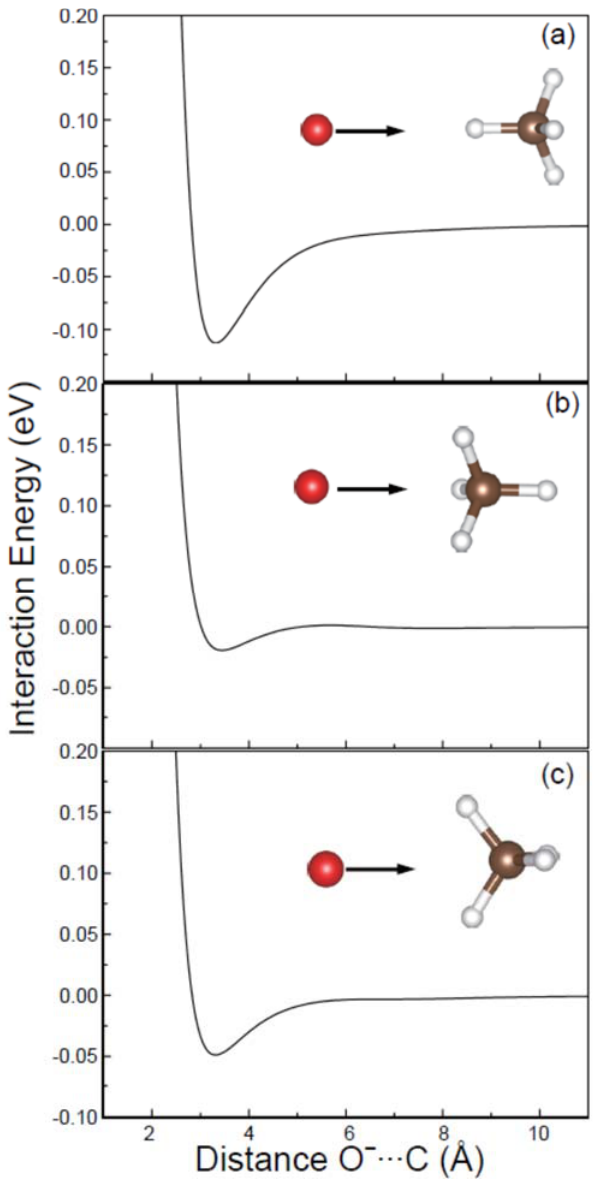
Figure 1. Interaction energy profiles for the attack of O − (in red) to CH 4 (H in white, C in brown) in the apex ( a ), center-of-plane ( b ) and center-of-edge-angle ( c ) directions.